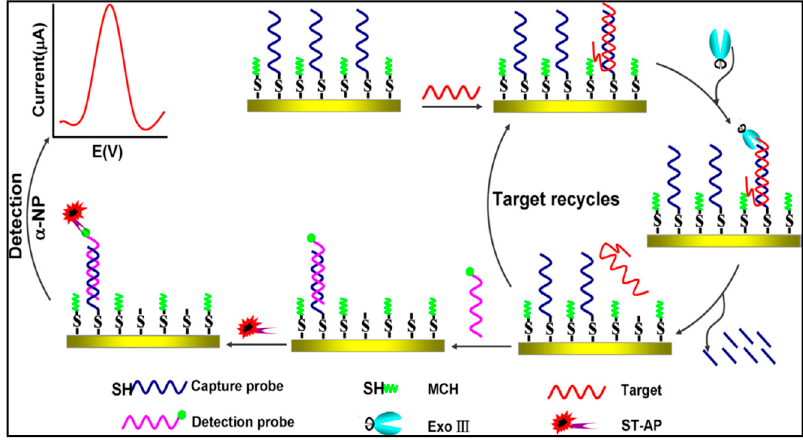
Figure 6. Electrochemical sensing methodology based on exonuclease III-assisted target recycling amplification technique for quantitative detection of Enterobacteriaceae bacteria [117]. Copyright 2013. Reproduced with permission from Elsevier B.V.